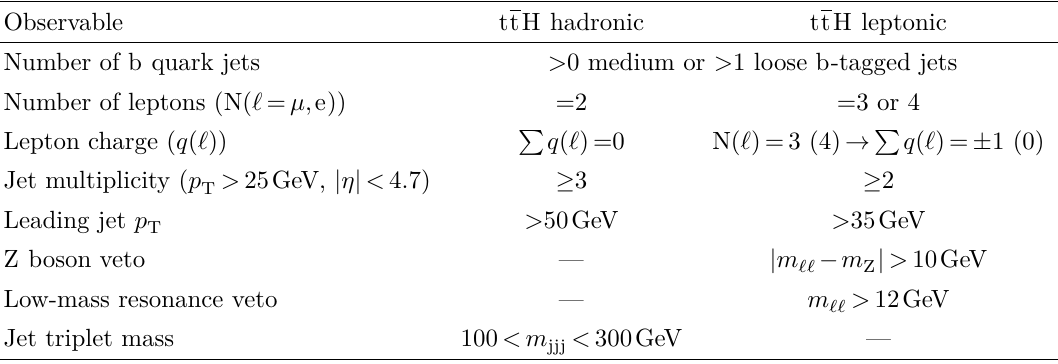
Table 5 . Summary of the kinematic requirements used to define the ttH hadronic and leptonic production